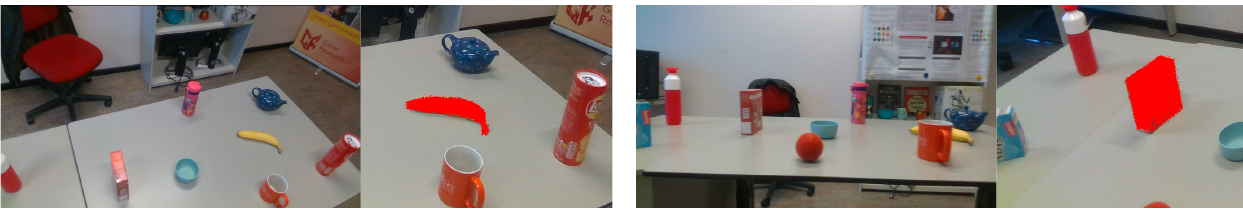
Figure 1. Scene examples and visualization of estimated poses by the approach that was proposed from our